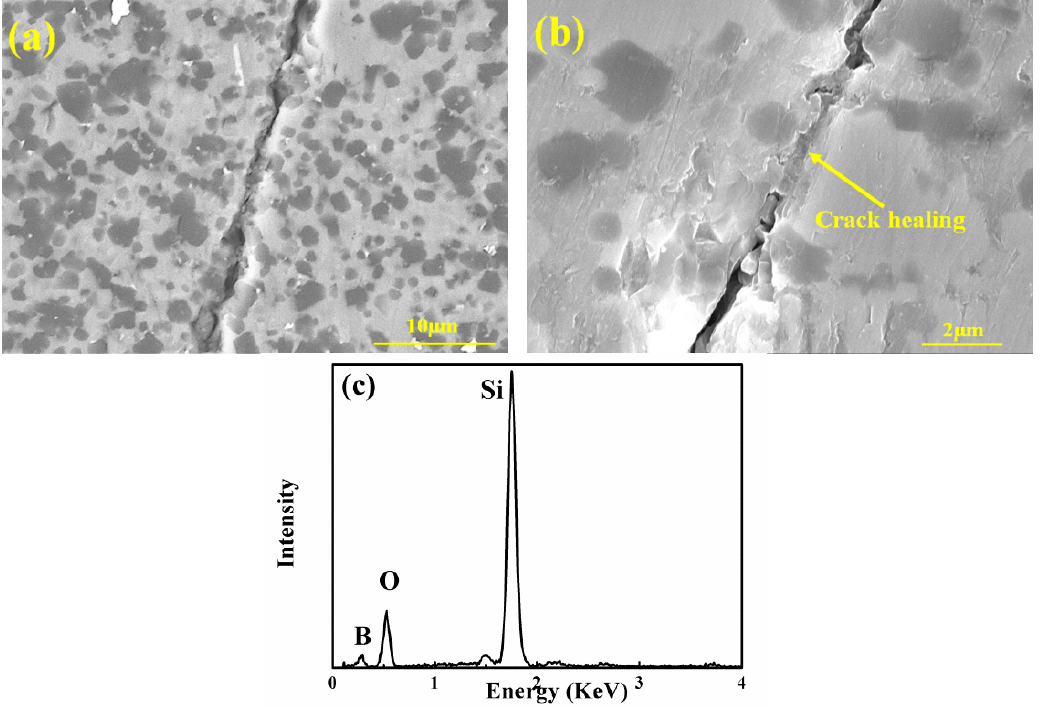
Figure 8. ( a ) Low-magnification and ( b ) high-magnification images showing the crack-healing phenomena, and ( c ) the EDS results of the glassy phase.